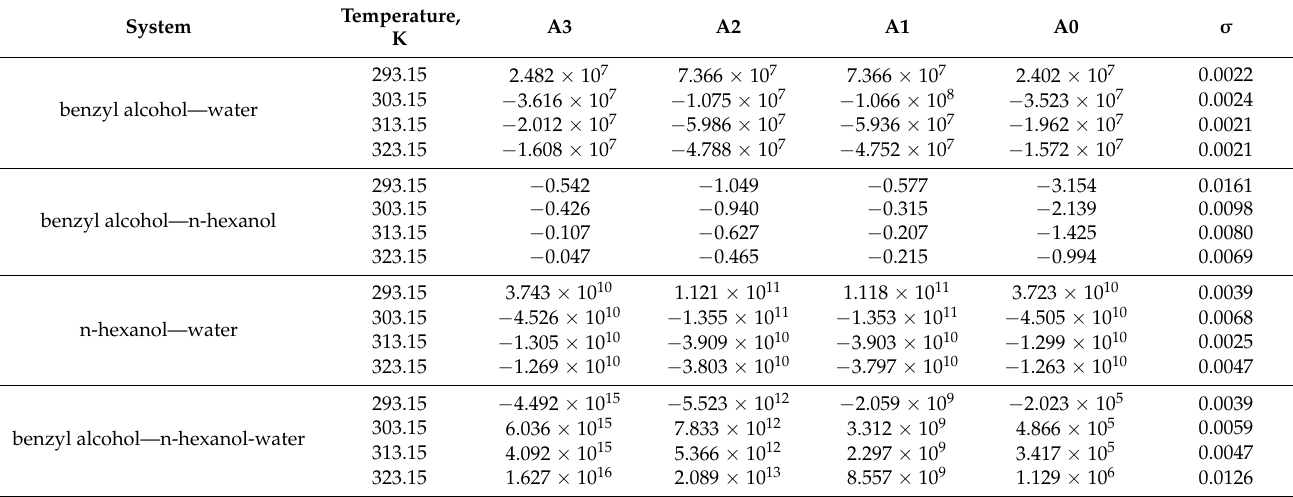
Table 4. Parameters and standard deviation for the Redlich and Kister